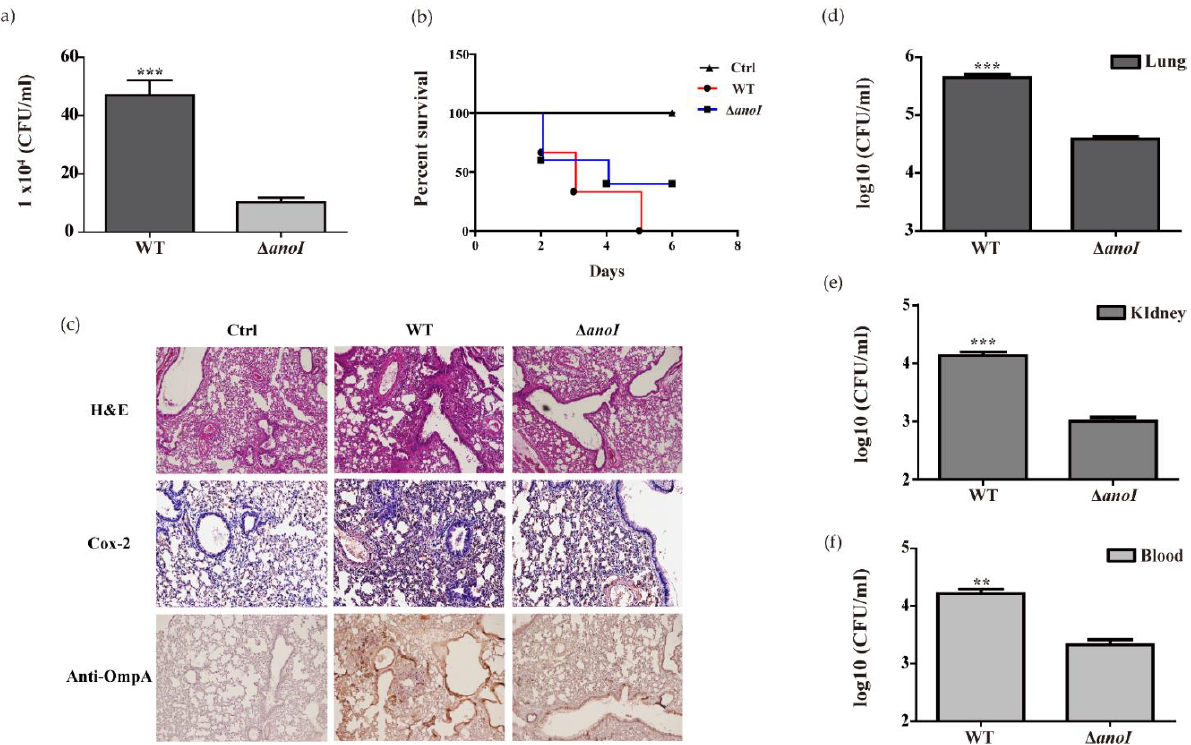
Figure 8. Lung colonization and virulence by A. nosocomialis . ( a ) BMDMs were infected with WT, Δ anoI , at an MOI of 100 for 6 h and incubated for 2 h in complete medium containing gentamicin, followed by additional incubation in complete medium for 16 h. Δ anoI . Data are presented as mean ± SEM of three independent experiments. ( b ) Survival curve of neutropenic BALB/c mice infected with A. nosocomialis . Neutropenic BALB/c mice were intratracheally infected with WT, ∆ anoI , and their survival rate was monitored twice a day. ( c ) Histological analysis of lungs in the mice three days post-infection. Representative histopathological sections of hematoxylin and eosin-stained lungs from neutropenic BALB/c mice infected with A. nosocomialis . Anti-OmpA antibody labeled lung sections WT, Δ anoI . The lungs of mice infected with WT and Δ anoI showed areas of inflammatory cell infiltration. Magnification: ×100. ( d – f ) Mice were intratracheally infected with A. nosocomialis strains and the number of bacteria in the lungs, blood, and kidneys three days post-infection was determined. Statistical significance was checked using Student’s t -test. ***, p < 0.001, **, p < 0.01 compared with Δ anoI.